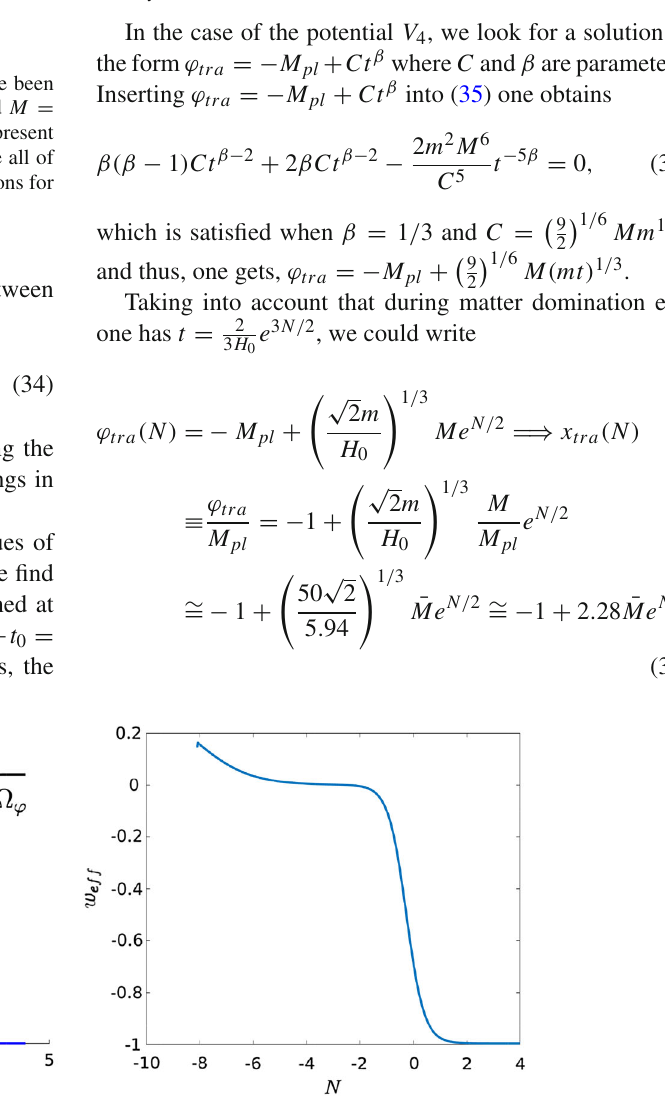
Fig. 3 In the left panel we show the evolution of the density param- eter (cid:13) for matter (blue curve), radiation (red curve), and the scalar field (black curve) while in the right panel we show the evolution of the effective equation of state parameter, w ef f (blue curve). In all the cases, during the numerical simulations, we assume α = 4, reheating temper- ature T rh = 100 TeV and M = 18 . 1 GeV. From both the left and right graphs, one can roughly estimate that at the present time (cid:13) ϕ (cid:14) 0 . 7,